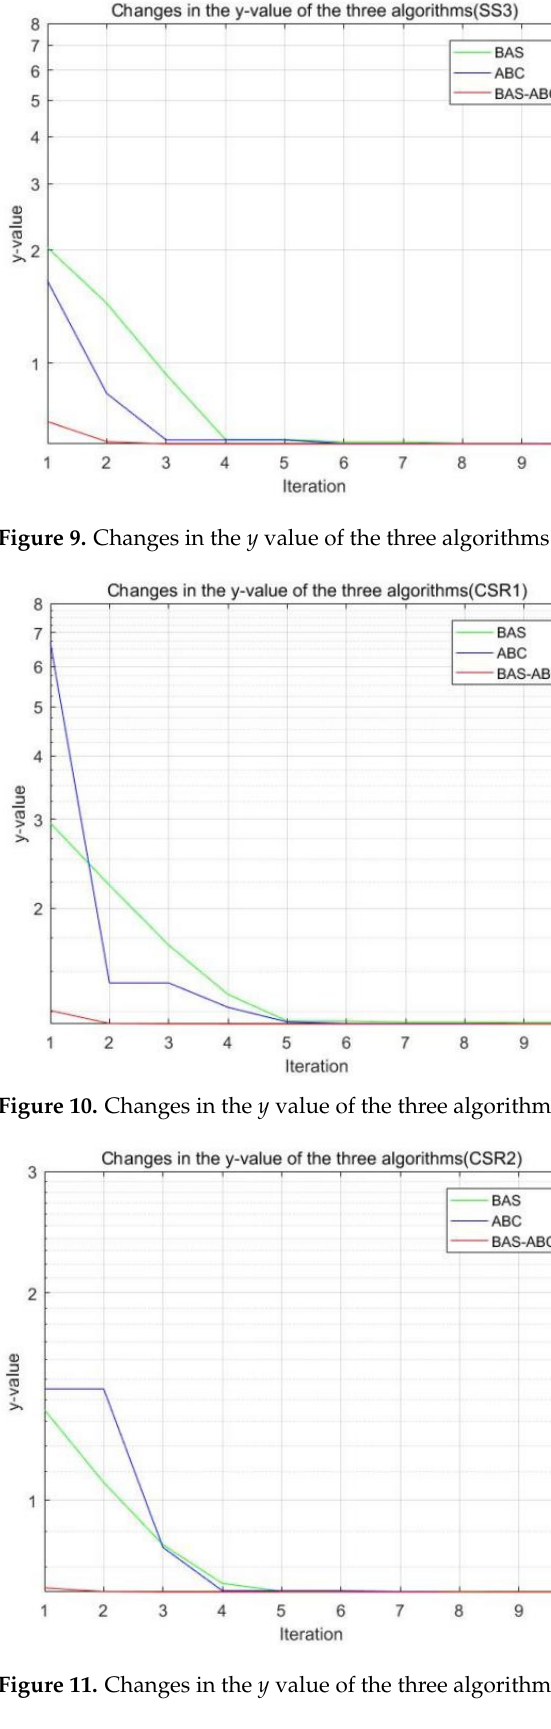
Figure 8. Changes in the 𝑦 value of the three algorithms (SYS1).